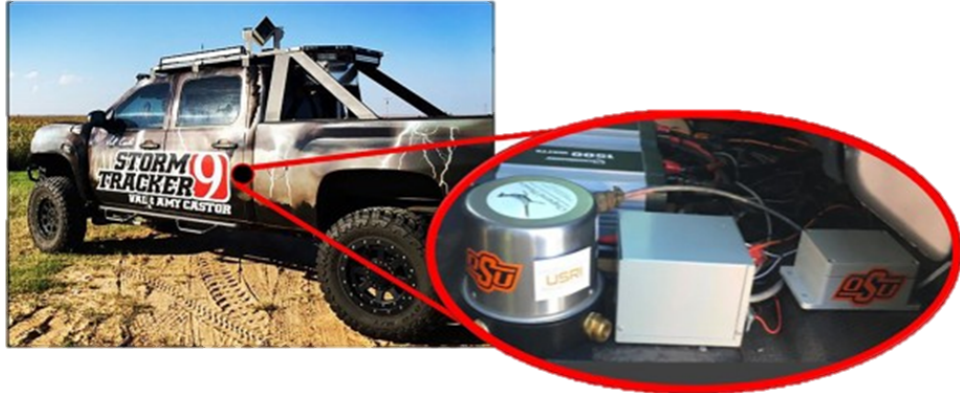
Figure 2. Image of the GLINDA-housing storm-chasing vehicle showing approximate location and configuration of install.